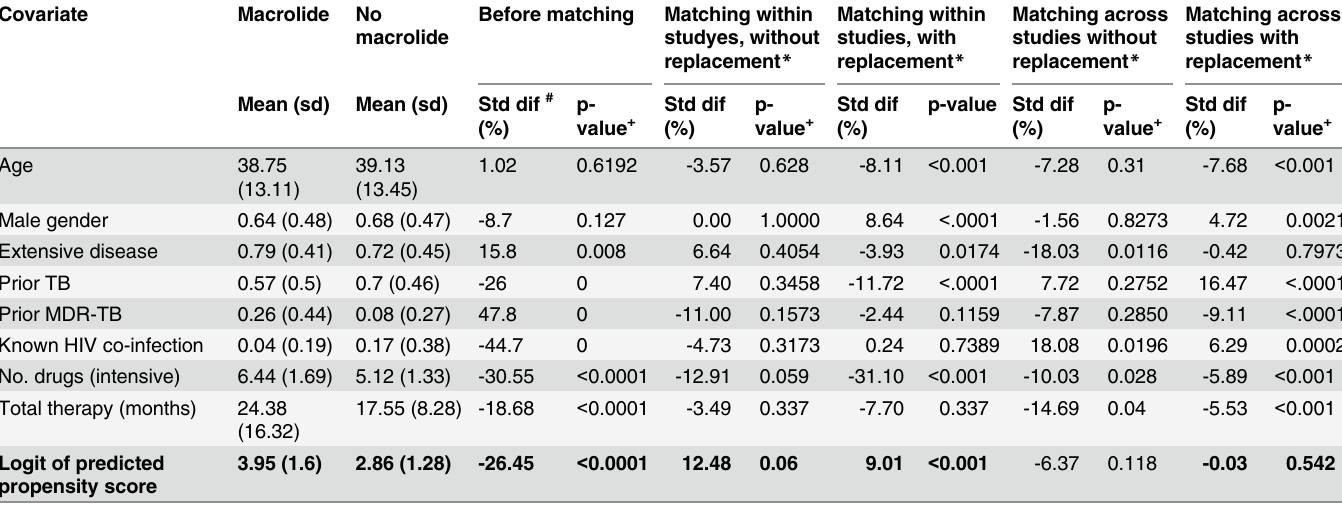
Table 6. Balancing achieved by different propensity score-based matching strategies for macrolide use. Covariate Macrolide Before